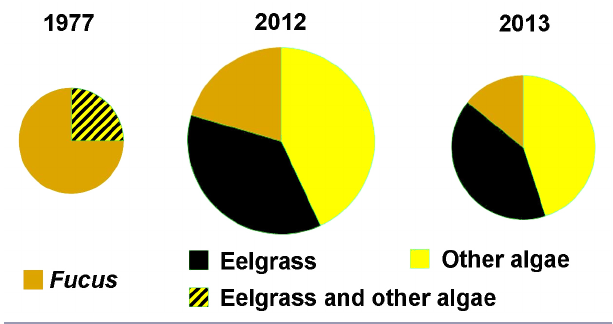
Fig. 3 . Contributions of eelgrass, Fucus, and other algal macrophytes to beach wrack at the Baltic Sea shore of Schleswig-Holstein in 1977 (Grave and Moeller 1982) and in the present study. Sizes of pie charts are relative to the absolute quantities of beach wrack in different years.